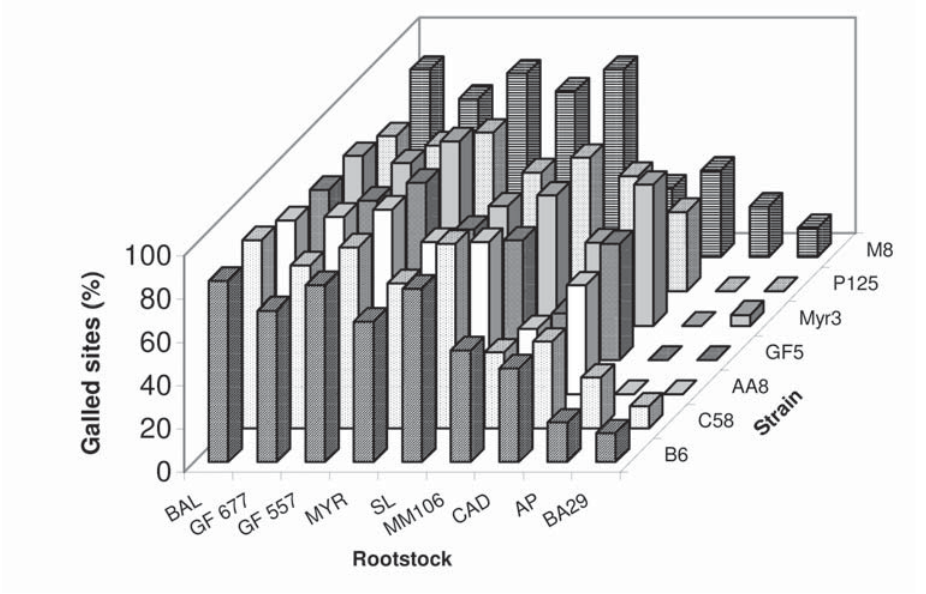
Fig. 4. Galled inoculation sites (%) after shoot inoculations with various strains of Agrobacterium tumefaciens. BAL, bitter almond; SL, Saint Lucie; MYR, myrobolan; CAD, Cadaman;